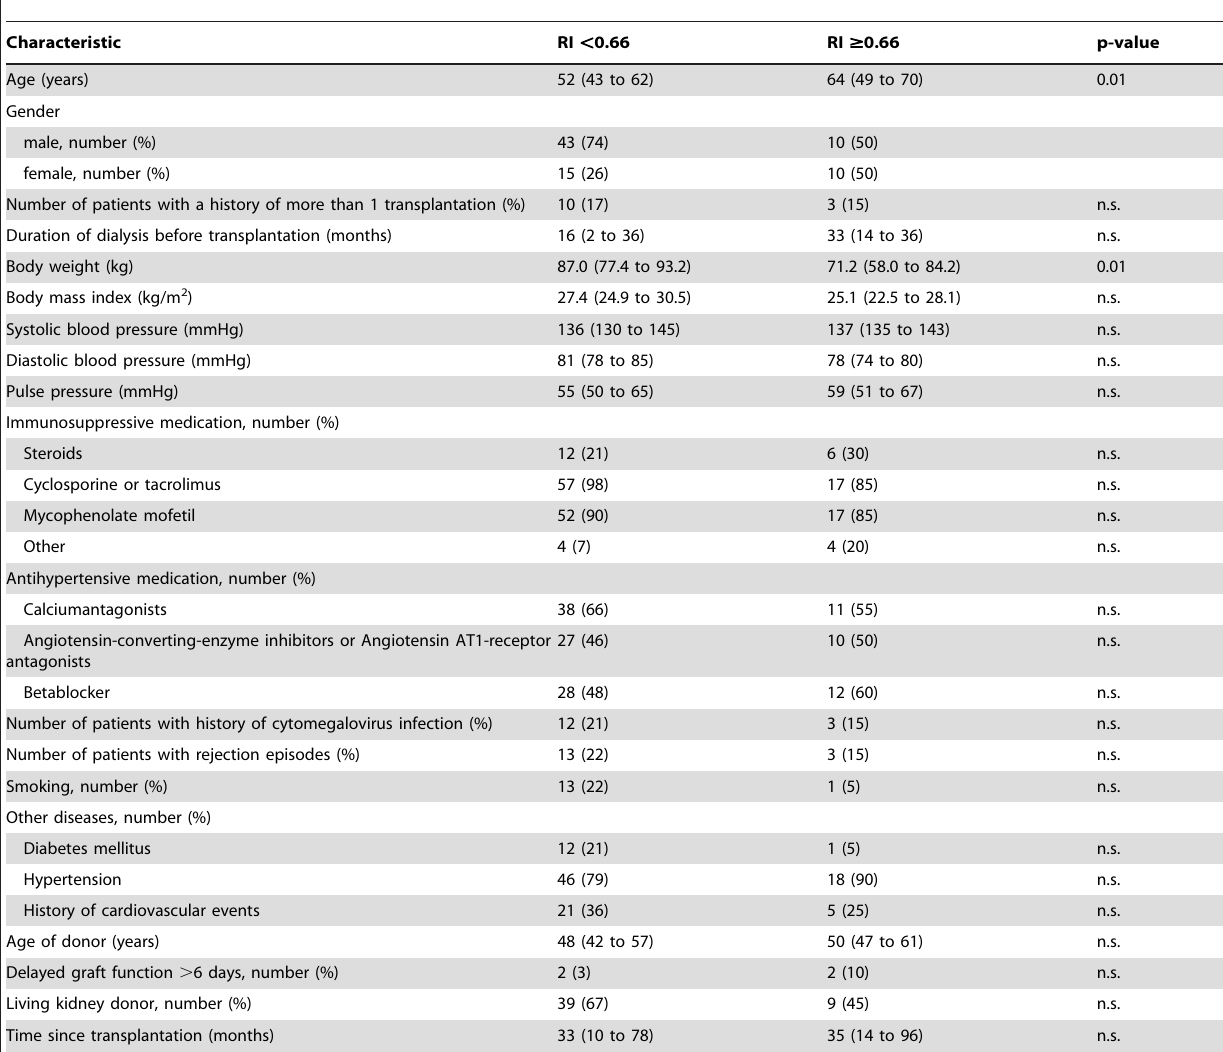
Table 1. Clinical characteristics of patients with renal